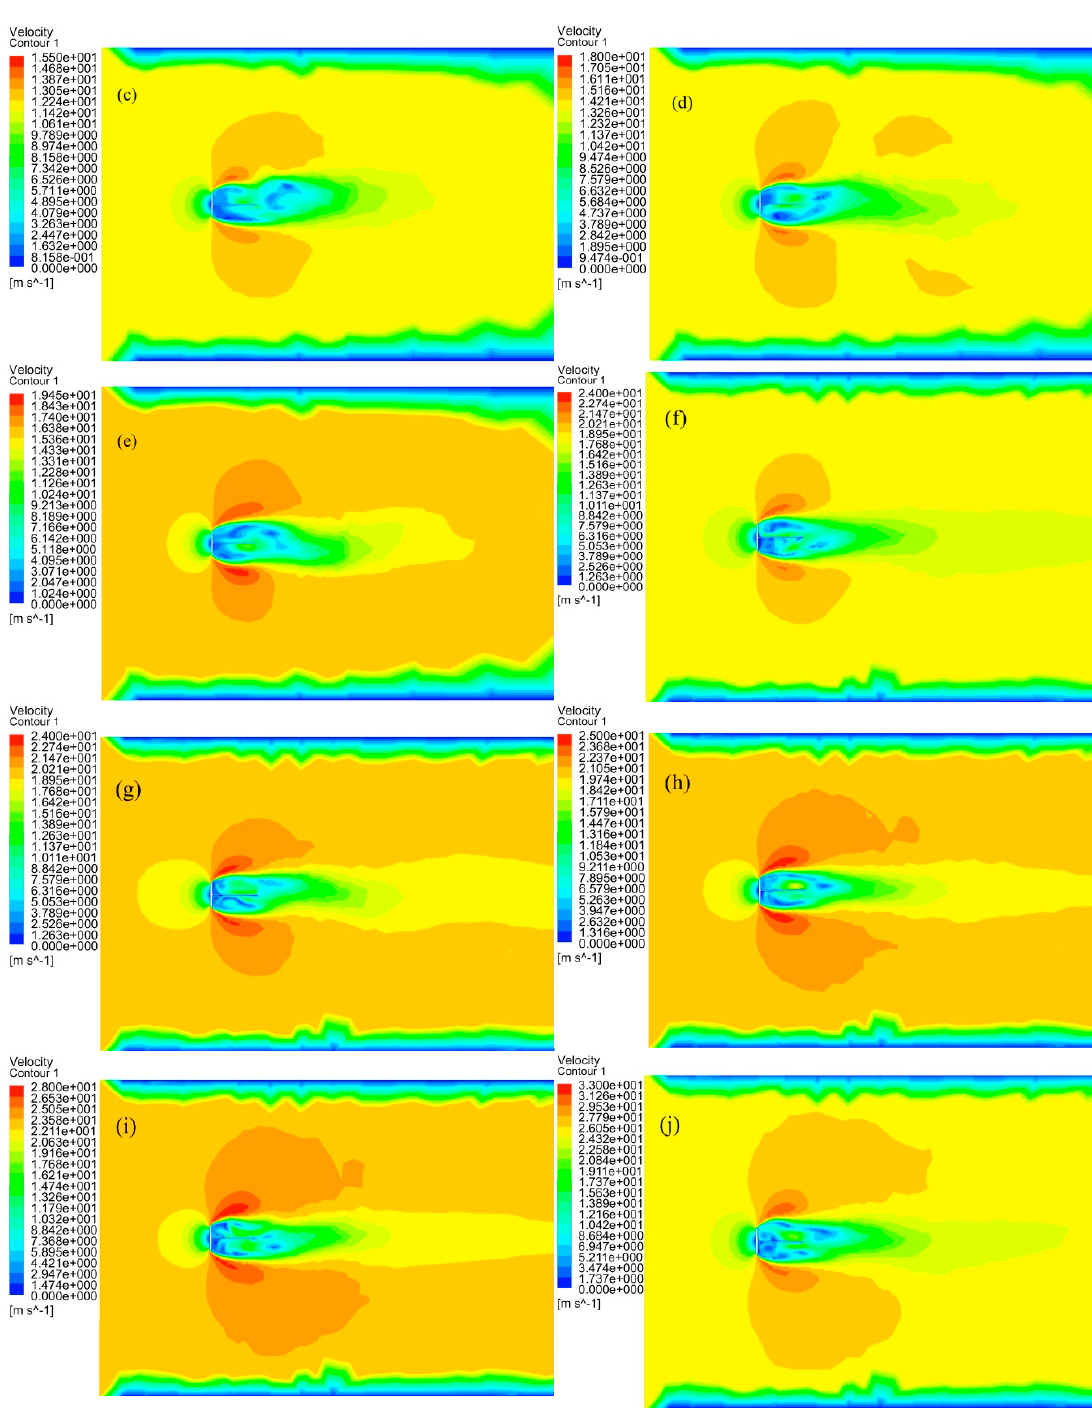
Figure 13. Velocity Contour at 0.3s with velocity ( a ) 7 m/s; ( b ) 10 m/s; ( c ) 12 m/s; ( d ) 14 m/s; ( e ) 16 m/s; ( f ) 18 m/s; ( g ) 19 m/s; ( h ) 20 m/s; ( i ) 22.5 m/s; ( j ) 25 m/s.